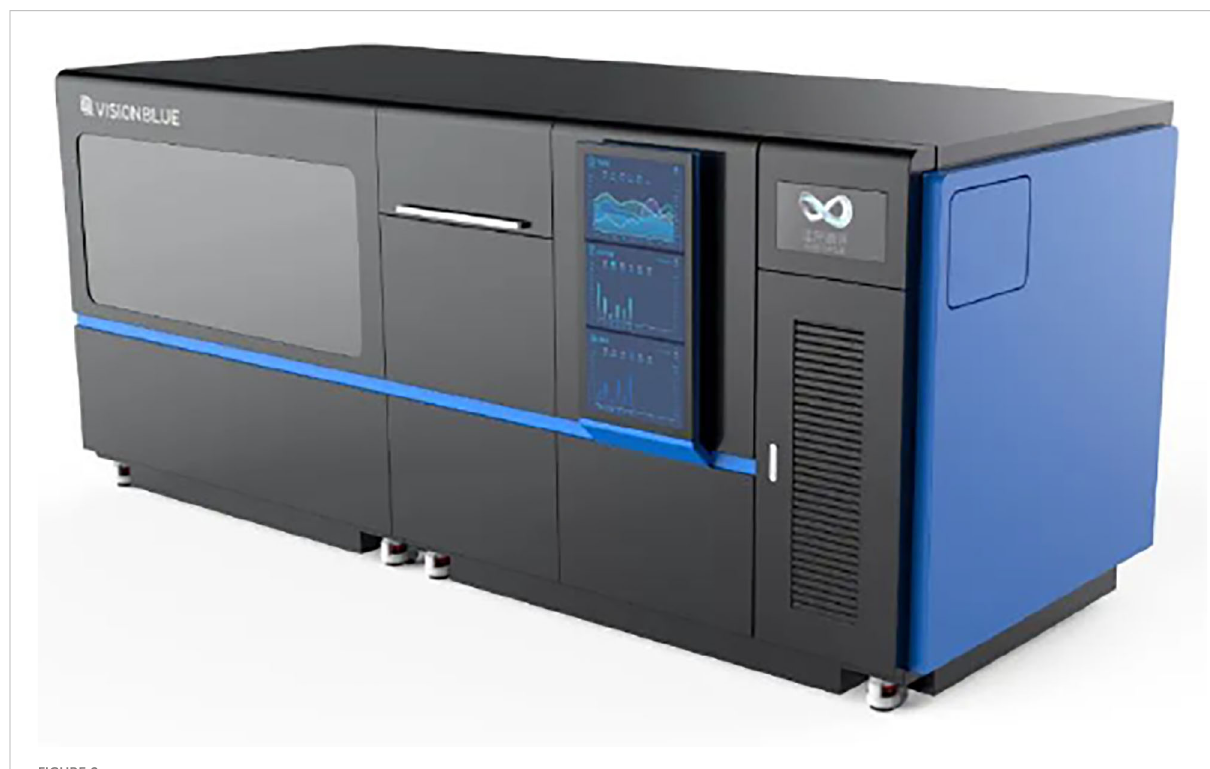
FIGURE 2 Blue Cloud Warehouse (Taizhou Ecological Environment Public,